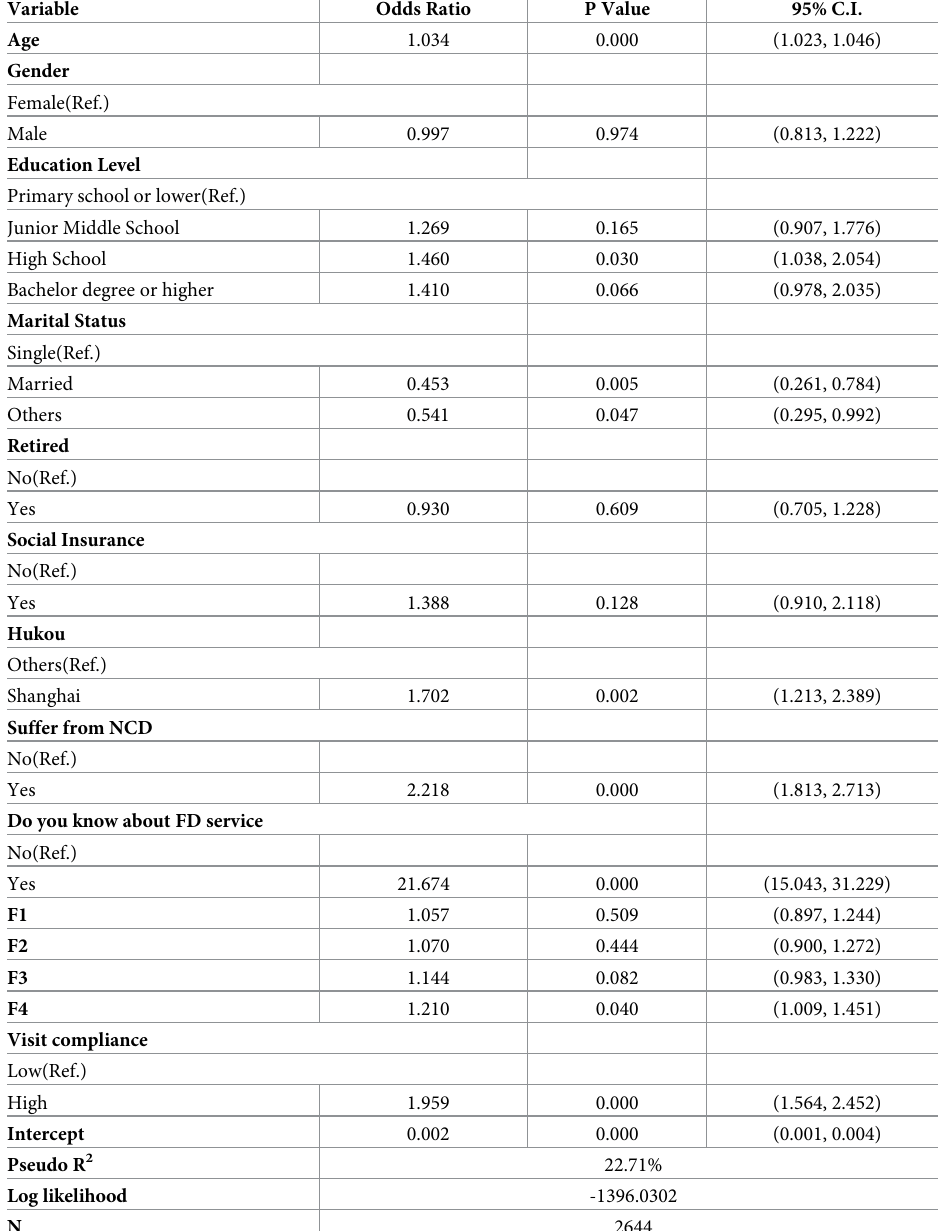
Table 4. Multivariate analysis of residents’ contract behavior,